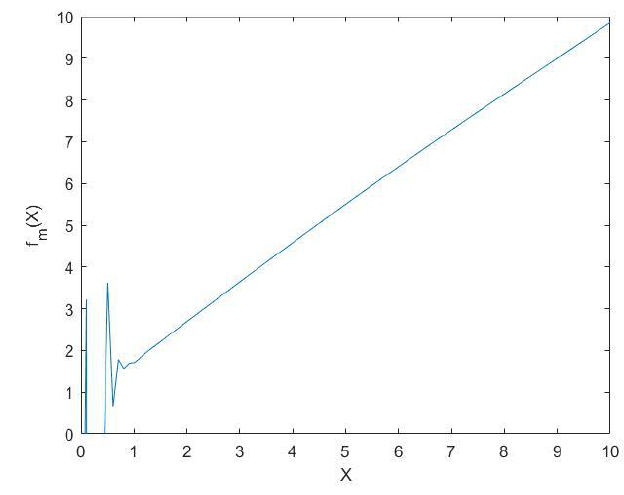
Figure 4. The function 𝑓 𝑚 (𝑋) for case 4, when μ = 9, 𝜎 = 1, 𝑘 = 1 .